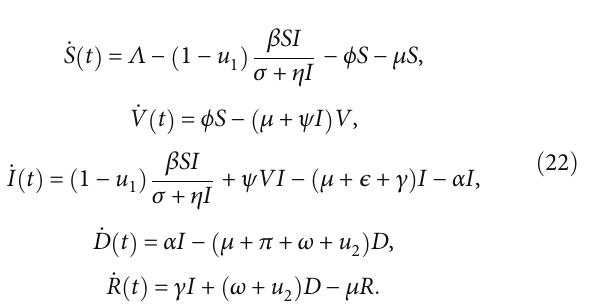
Figure 16: Quarantined individuals with and without prevention strategy u 1 and intervention strategy u 2 .